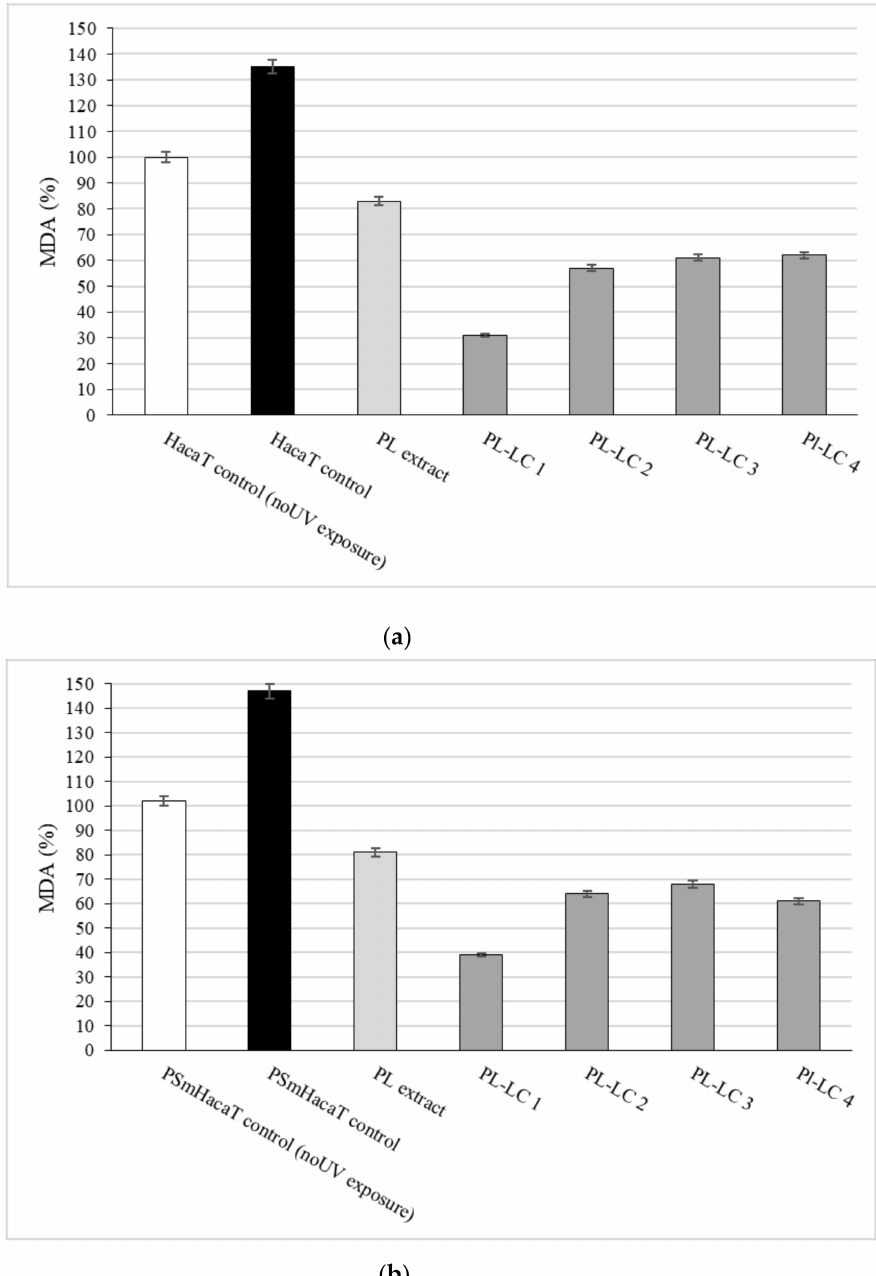
Figure 7. Effect of LC-PL-compositions on HaCaT ( a ) and PSmHaCaT ( b ) MDA levels after 6 min of UV exposure. The positive control PL extract was water. The negative controls were the untreated cells and UV-induced untreated cells. Values are expressed as means ± SD, n = 5. Significant differences between LC-PL-composition groups and the control group are marked with an